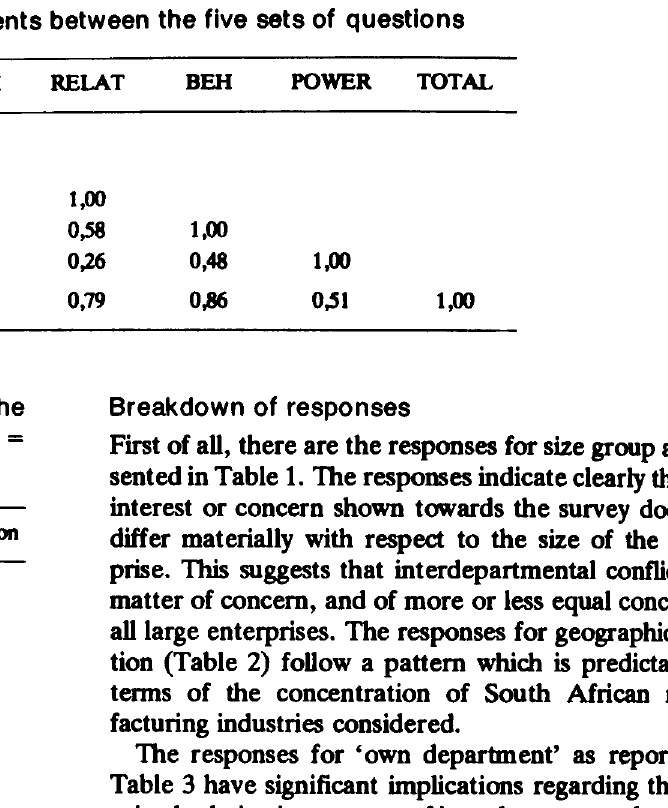
Table 7 Means and standard deviations of the 24 questions (Total cases for each question =